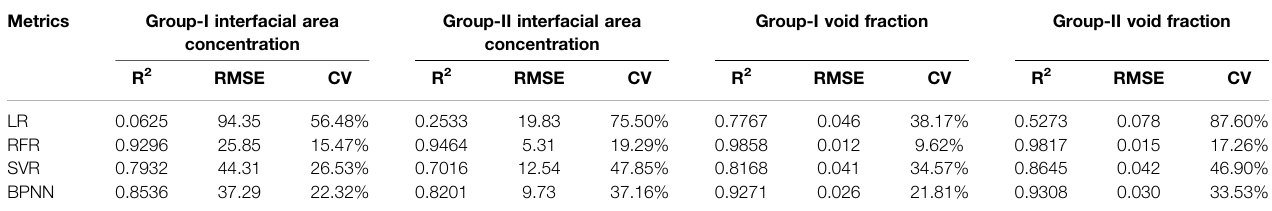
TABLE 3 | The learning ability of the four models derived from the test set in terms of four two-phase fl ow parameter changes. Metrics Group-I interfacial area